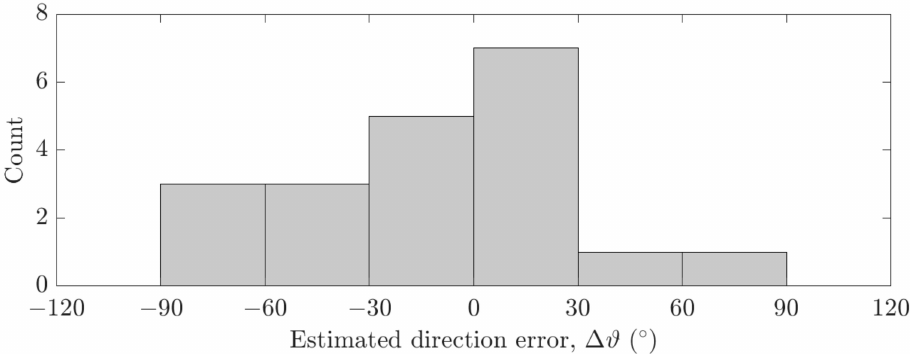
Figure 5. Histogram of estimated direction error, ∆ ϑ . The relatively high counts near 0 ◦ indicate the estimations are good with minimal